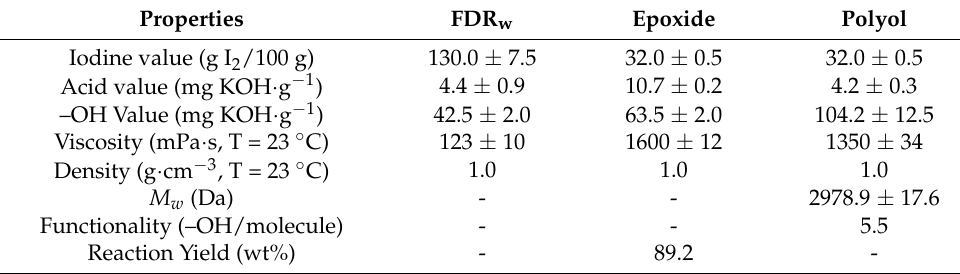
Table 1. Materials’ chemical-physical characterization (FDR w , Epoxide, and Polyol).